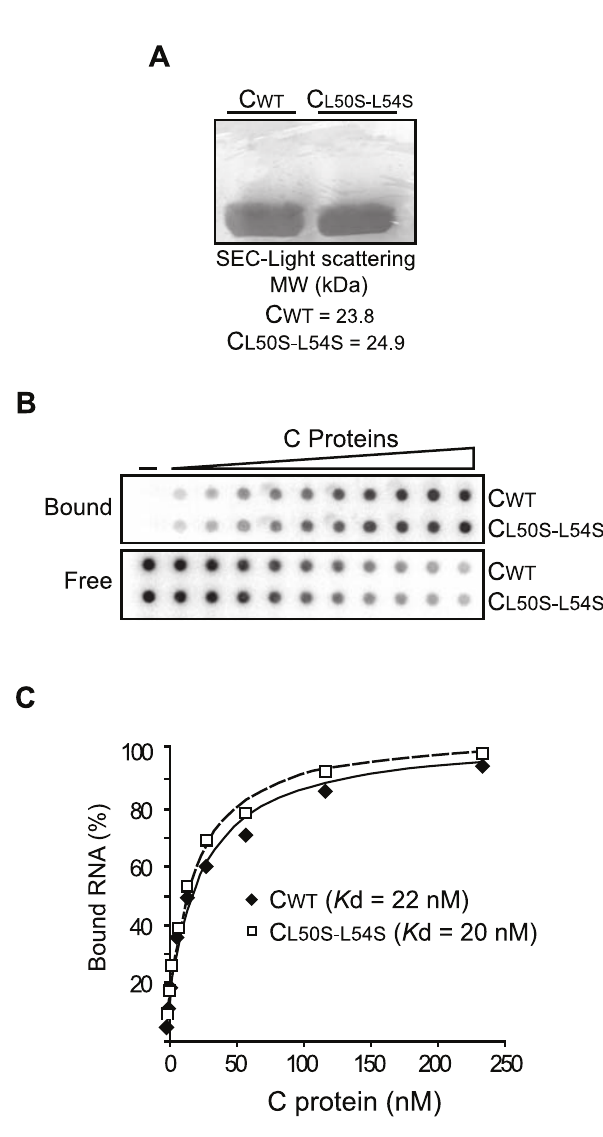
Figure 4. Biochemical properties of recombinant C protein with substitution L50S–L54S. A. High expression levels and dimerization of C WT and C L50S–L54S . SDS-PAGE stained with coomassie blue showing similar expression levels of the recombinant proteins. The molecular mass obtained by size exclusion chromatography (SEC) and light scattering for both proteins are indicated. B. Interaction of C WT and C L50S–L54S with the DENV 5 9 UTR RNA probe monitored by filter binding assay. Uniformly 32 P labeled RNA (0.1 nM) was incubated with increasing concentrations of the respective C protein. Bound indicates RNA-protein complexes retained in the nitrocellulose membrane and free denotes the unbound probes retained in the nylon membrane. The RNA probes bound and free in each membrane were visualized by PhosphoImaging. C. Quantification of the percentage of RNA probe bound was plotted as a function of C concentration and fitted using equation 1 (see Materials and methods). The dissociation constants K ds are indicated inside the